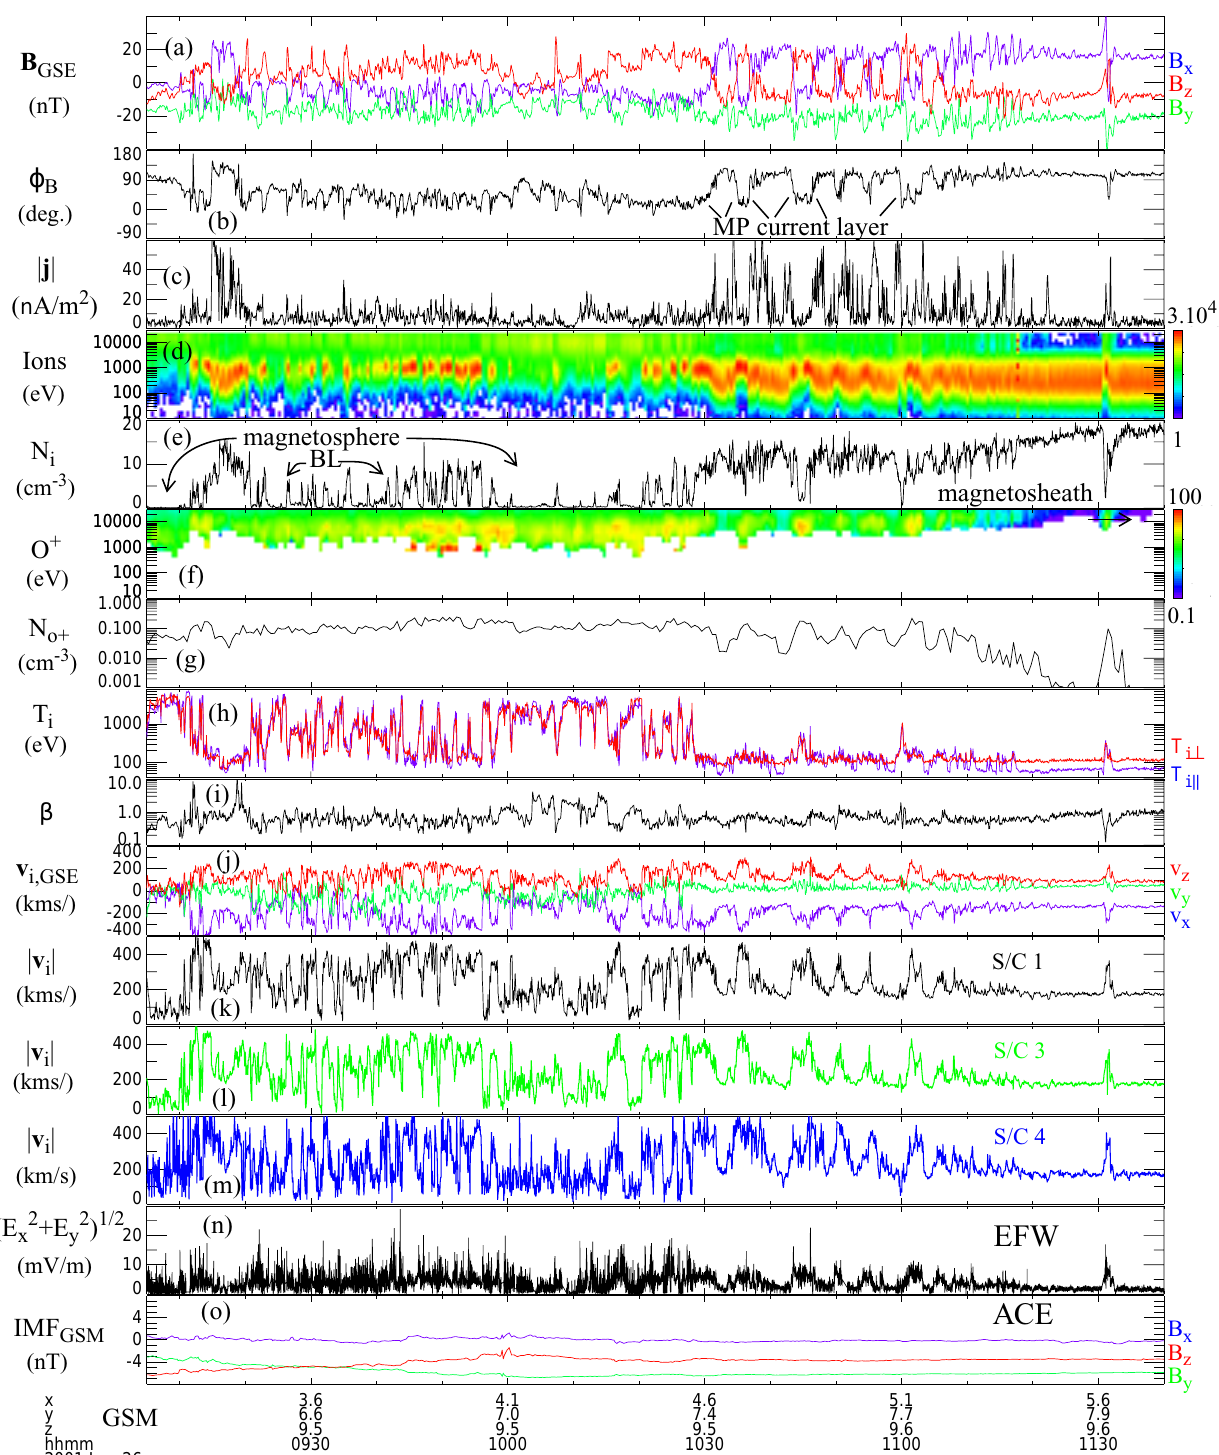
Figure 2. Panels a-n display measurements in the magnetosphere/MP/magnetosheath from Cluster spacecraft 1 except noted. Panel o shows ACE solar wind magnetic field data. (a) Magnetic field components in GSE, (b) magnetic field angle in the plane tangential to the MP with zero degree approximately along GSM z, (c) current density computed from ∇× B using B from all 4 spacecraft, (d) ion energy-time spectrogram (in eVs -1 cm -2 ster -1 eV -1 ), (e) ion number density, (f) O + spectrogram, (g) O + number density, (h) perpendicular (red) and parallel (purple) ion temperatures, (i) plasma β , (j) ion flow components in GSE, (k) – (m) ion flow speed from spacecraft 1, 3, and 4, respectively, (n) electric field magnitude (E 2 x +E 2 y ) 1 / 2 , (o) interplanetary magnetic field components in GSM.